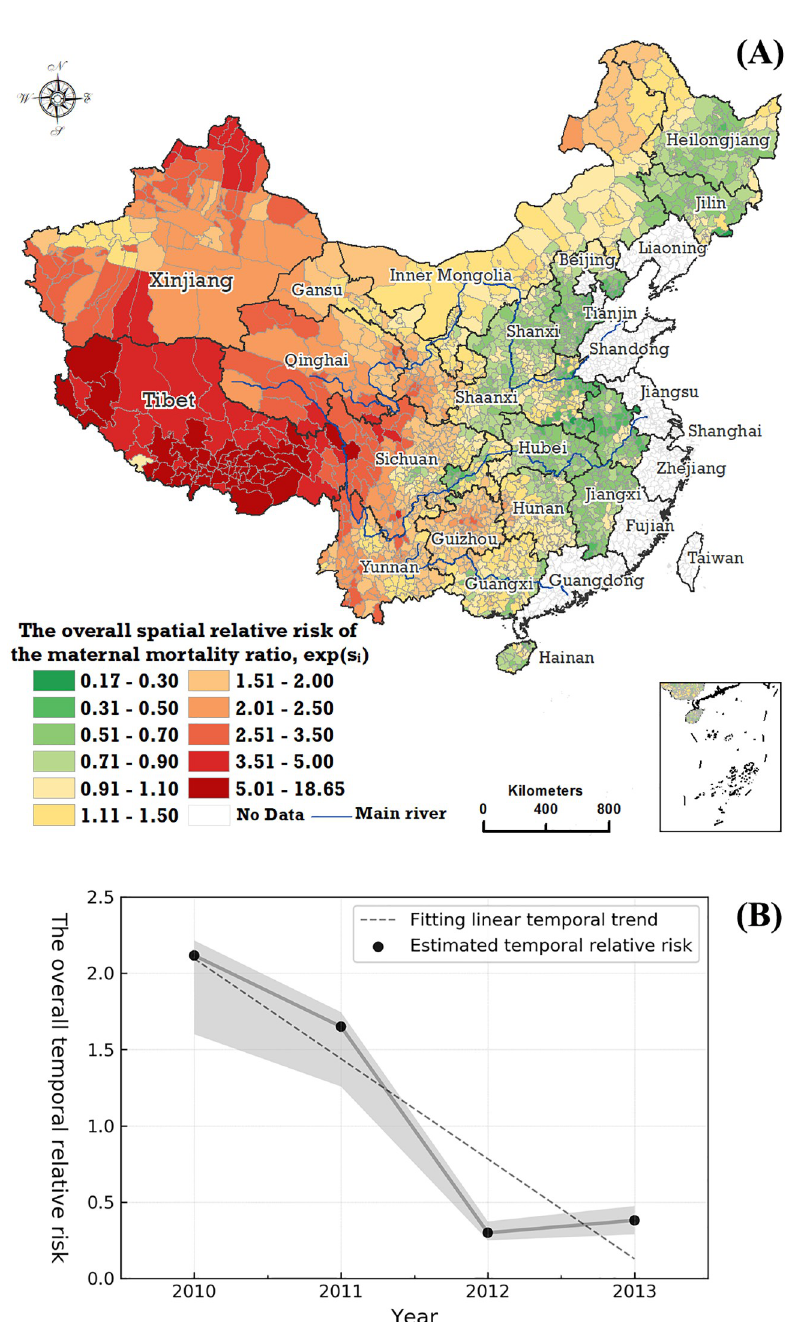
Fig 3. The overall spatial relative risk trends of the MMR in China over the period 2010–2013. (A) The posterior median of the spatial relative risks (exp( s )) in counties and (B) the overall temporal trend, with the posterior median of i the temporal relative risk ( exp ( b 0 t � + v t )) having a probability of 95%. MMR, maternal mortality ratio. downward trend, with Heilongjiang’s northern and eastern regions also experiencing a stron- ger local downward trend. Most of the areas of Tibet and west Xinjiang and the areas near the eastern regions of China indicate a weaker decline in the local trend than the national down- ward trend.